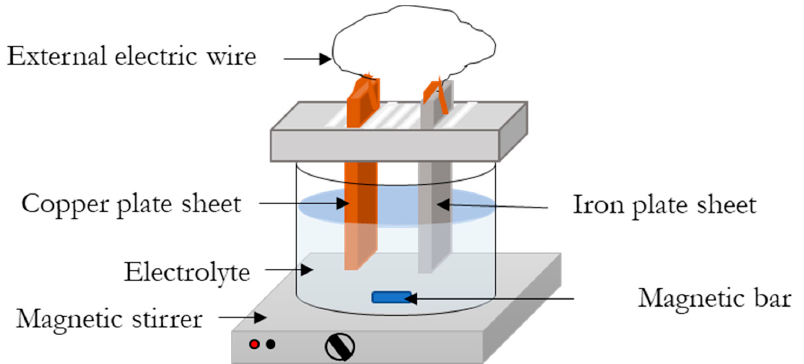
Figure 11. Considered configuration in the modeling of the Galvano-Fenton process.